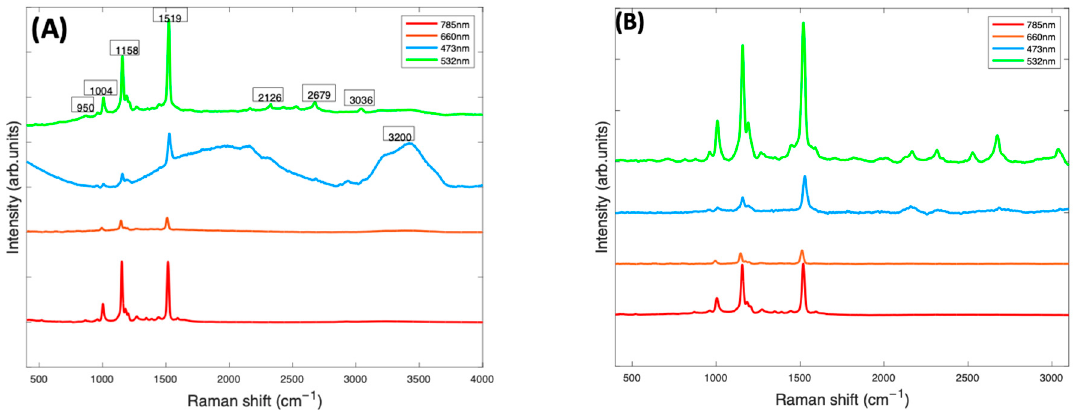
Figure 3. ( A ): Smoothed Raman spectra of Beta Carotene/BSA complex solution (1 mg/mL) at 4 different wavelengths—473 nm (blue), 660 nm (orange red), 532 nm (green), and 785 (red) taken with a x10 objective. ( B ): Raman spectra of Beta Carotene (1 mg/mL) taken at four different wavelengths after background correction. The spectra have been offset for clarity.